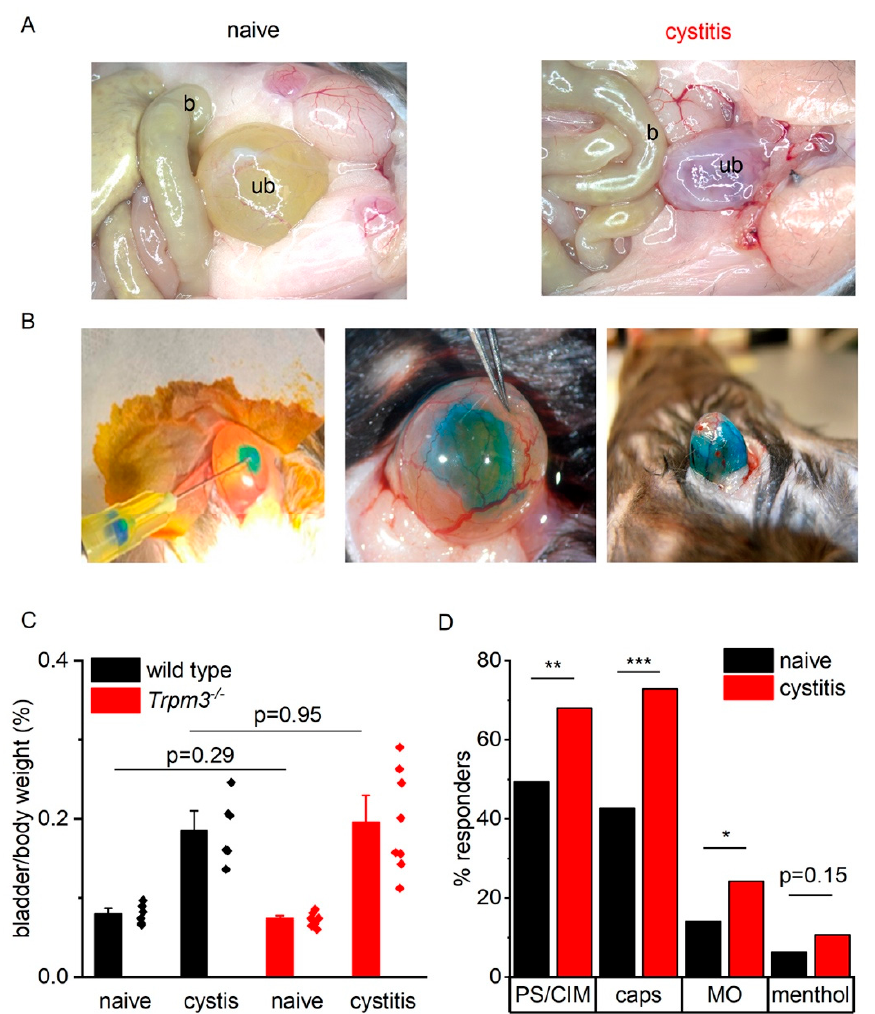
Figure 5. Calcium imaging during bladder inflammation. ( A ) Macroscopic view of a sham-treated bladder (left) and a CYP-treated bladder (right) 24 h after injection. b = bowel, ub = urinary bladder. ( B ) Injection of WGA-AlexaFluor 555 into the bladder wall and spreading of the dye over the bladder wall. ( C ) Bladder weight to body weight ratios in naive and CYP-treated wild type ( n = 12) and Trpm3 − / − mice ( n = 15). ( D ) Percentage of bladder afferent neurons responding to TRP channel agonists in mice with and without bladder inflammation ( n = 214 neurons from 3 mice and 103 neurons from 3 mice, respectively). * p < 0.05; ** p < 0.01; *** p < 0.001.